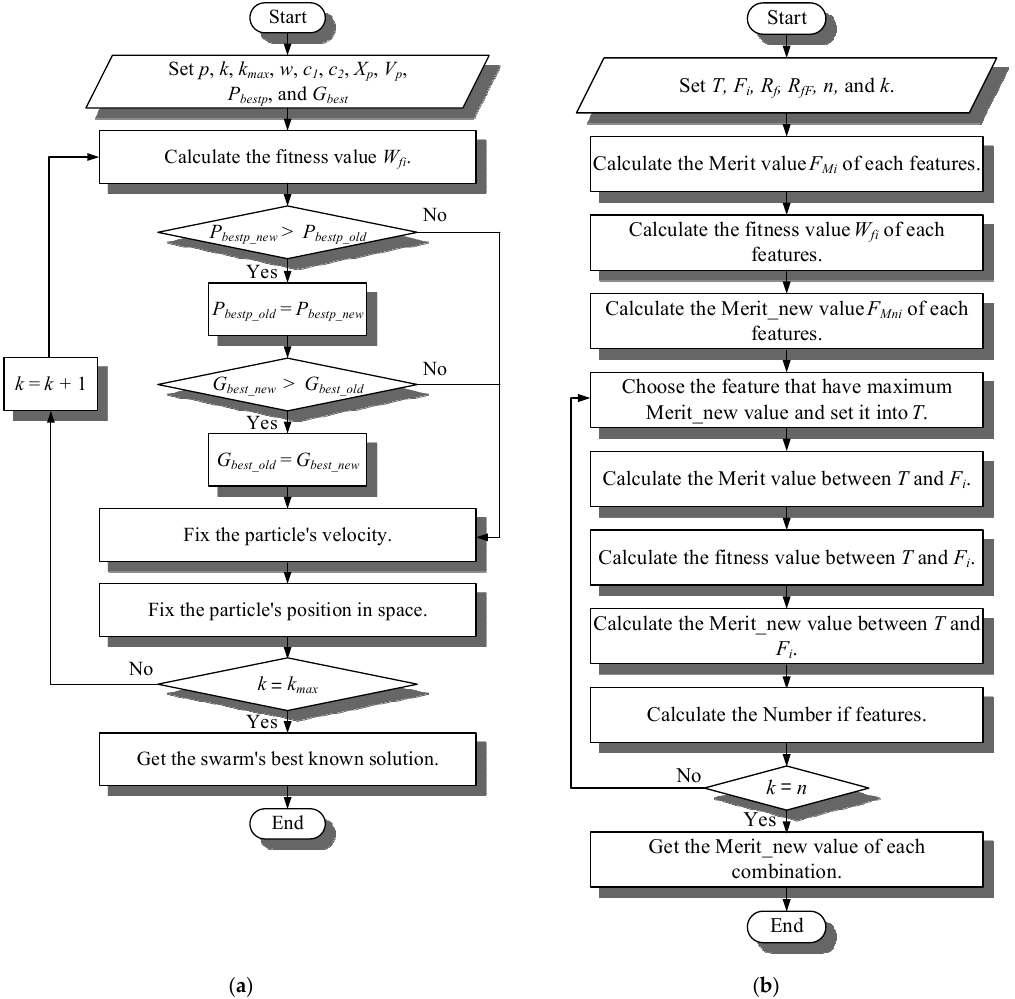
Figure 10. Flowchart of the correlation and fitness value-based feature selection (CFFS). ( a ) Calculates the fitness value; ( b ) calculates the merit_new.